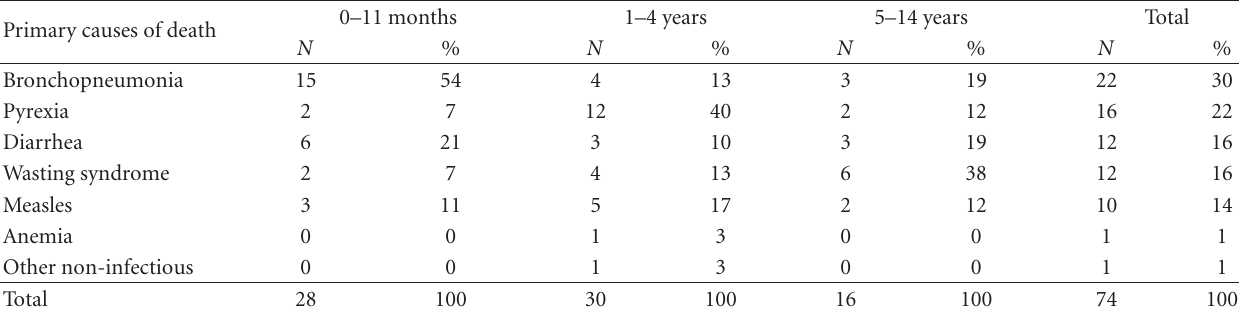
Table 4: Primary causes of death in children with confirmed HIV infection, according to age ( n =